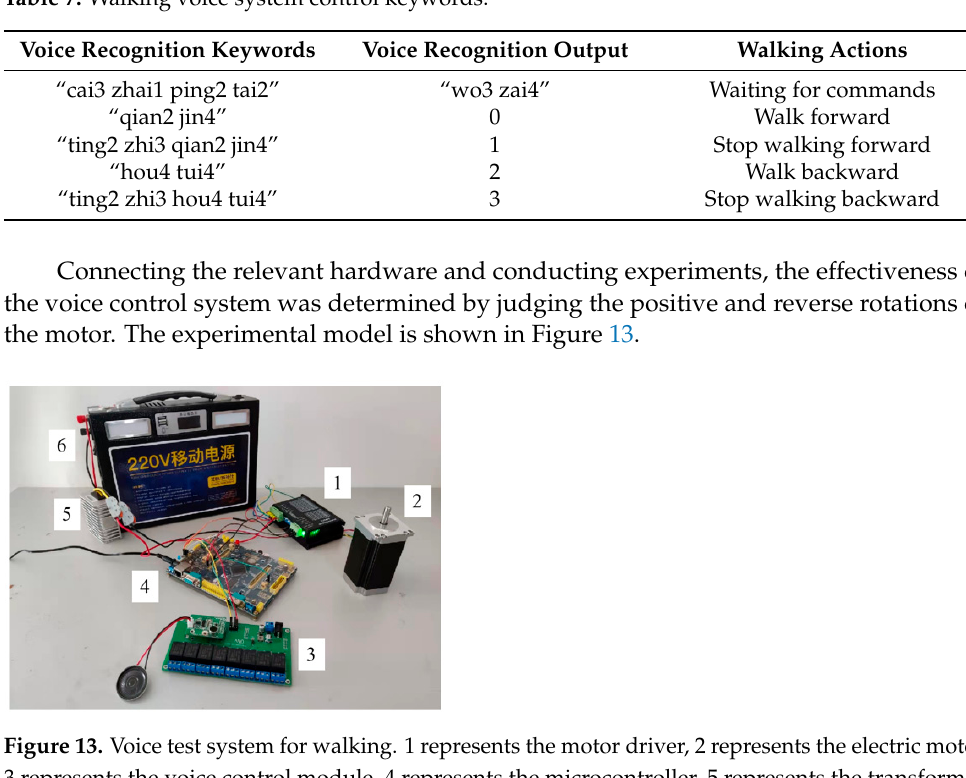
Table 8. Recognition accuracy of the walking voice system in the two environments.